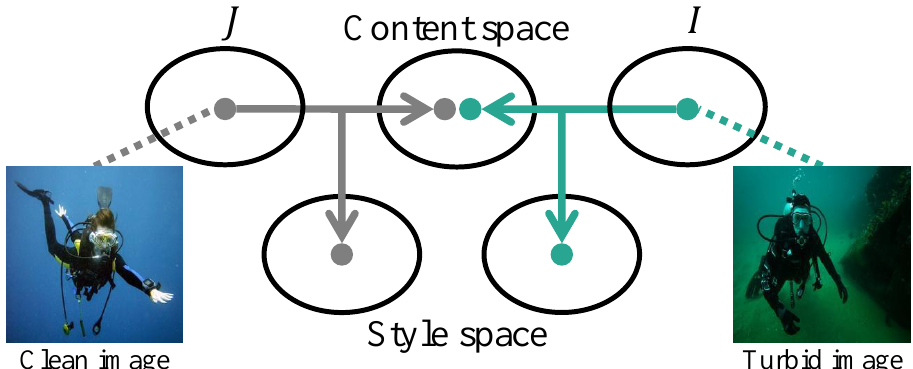
Figure 4. Diagram for the relationship between the turbid domain and the clean domain in feature